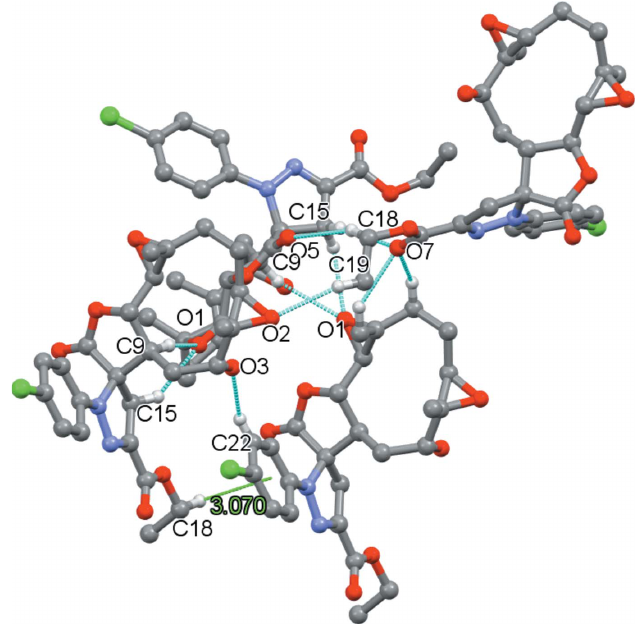
Figure 2 A projection showing the molecules connected by hydrogen bonds